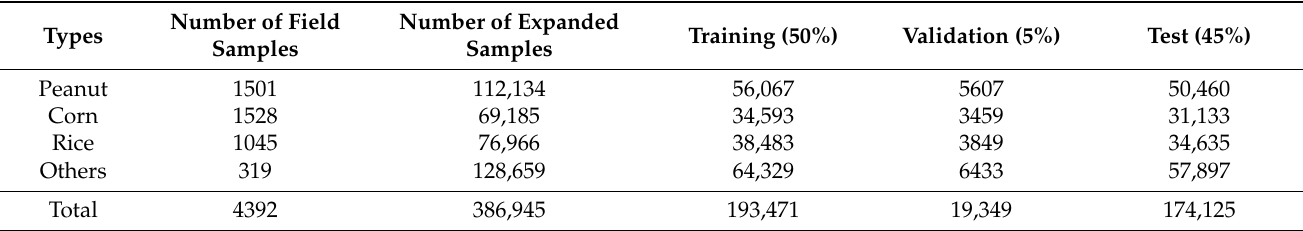
Table 2. The number of expended reference samples that were divided into training, validation, and test samples at a ratio of 10:1:9.